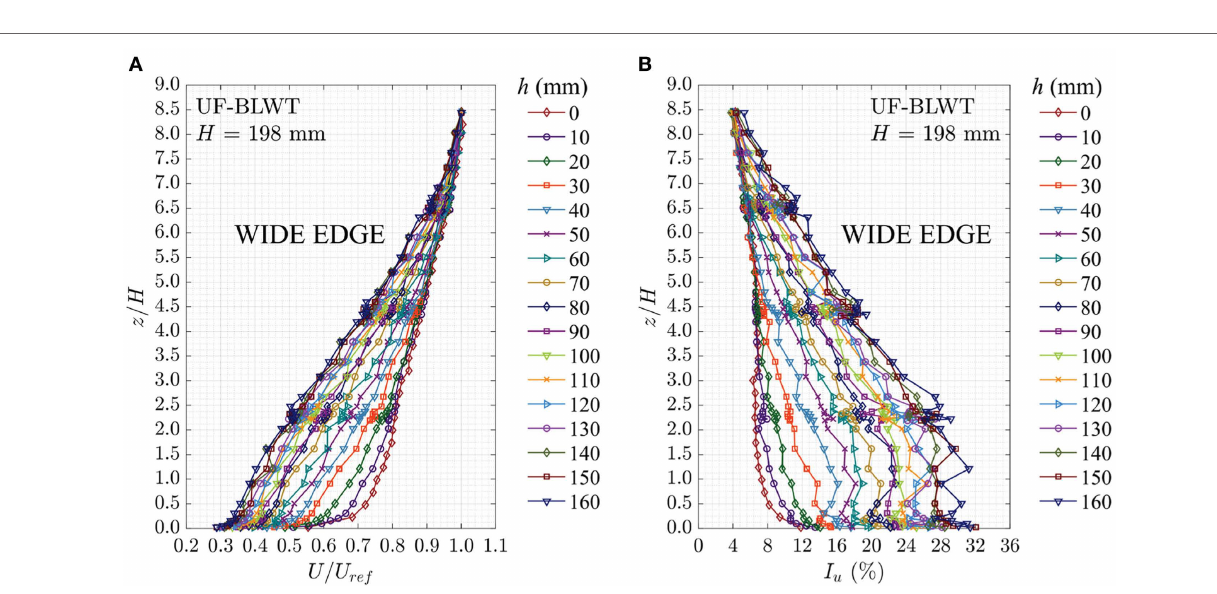
Frontiers in Built Environment |